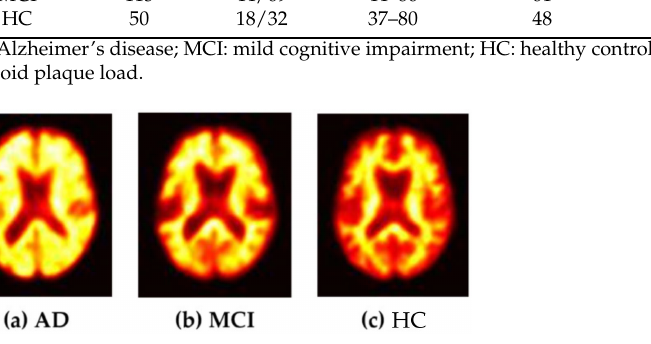
Figure 1. Preprocessed FBB images of subjects. ( a ) FBB image of AD. ( b ) FBB image of MCI. ( c ) FBB image of HC.